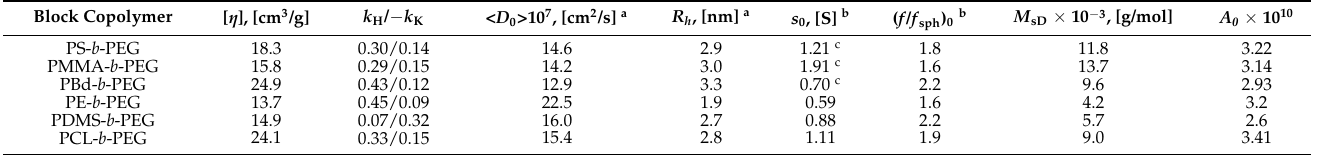
Figure 2. The normalized specific viscosity η sp / c vs. concentration c , obtained for the studied copolymers in THF at 20 ◦ C. Table 2. Hydrodynamic parameters of block copolymers in THF at 20 °C.